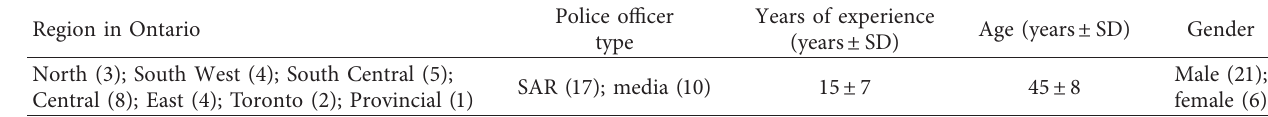
Table 1: Participant characteristics ( n � 27).